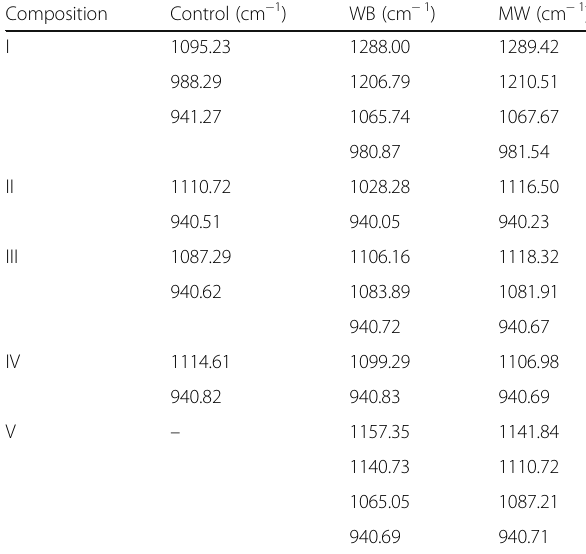
Table 3 FT-IR absorption peaks of SO 42 − in chromium complex from each component in 0% basicity chromium sulphate tanning liquor